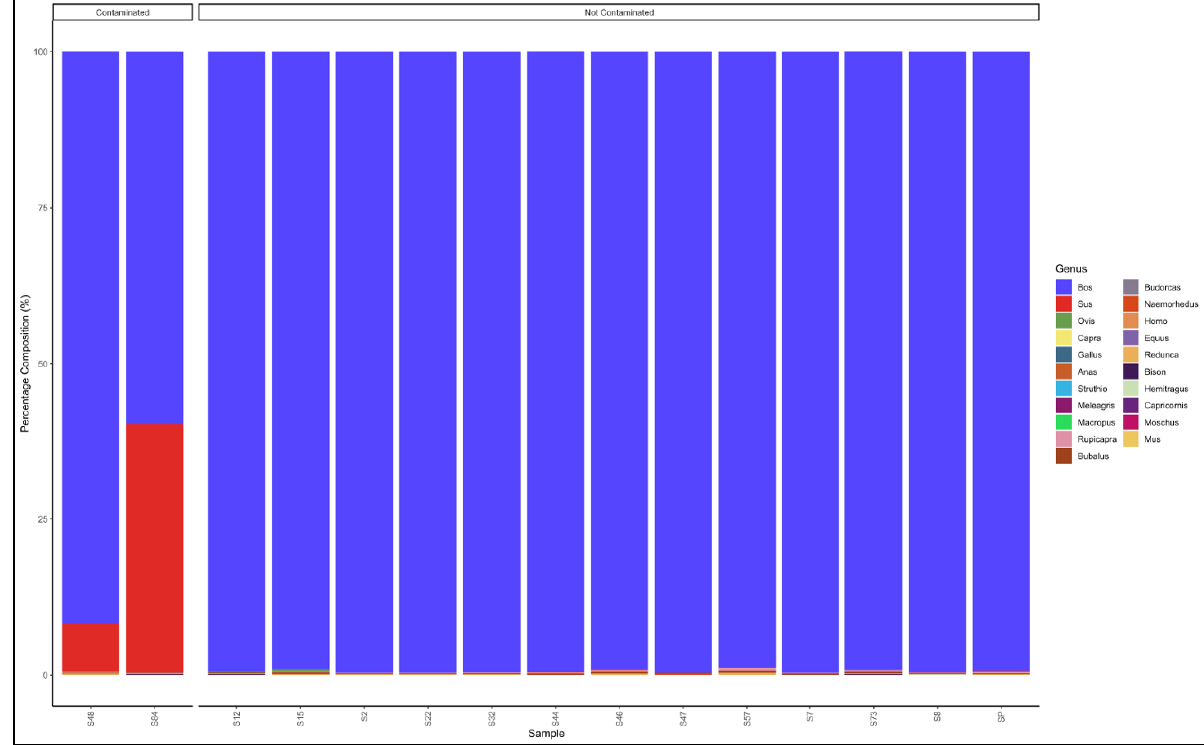
Figure 8. Percentage composition of patty samples not specified which species they are from.